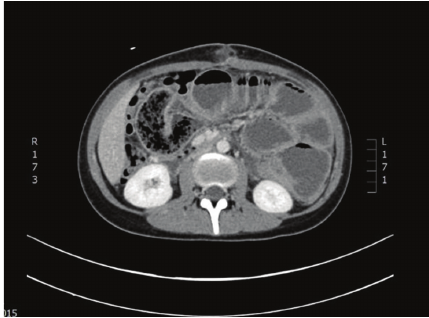
Figure 2: Preoperative CT showing scattered dilated loops of small bowel, measuring up to 45mm in the left flank. Within the right upper quadrant, there is a short loop of small bowel, which contains speckled faecal matter. There is the impression of twisting in the adjacent mesentery. Figure 3: The residual trichobezoar mass recovered from the